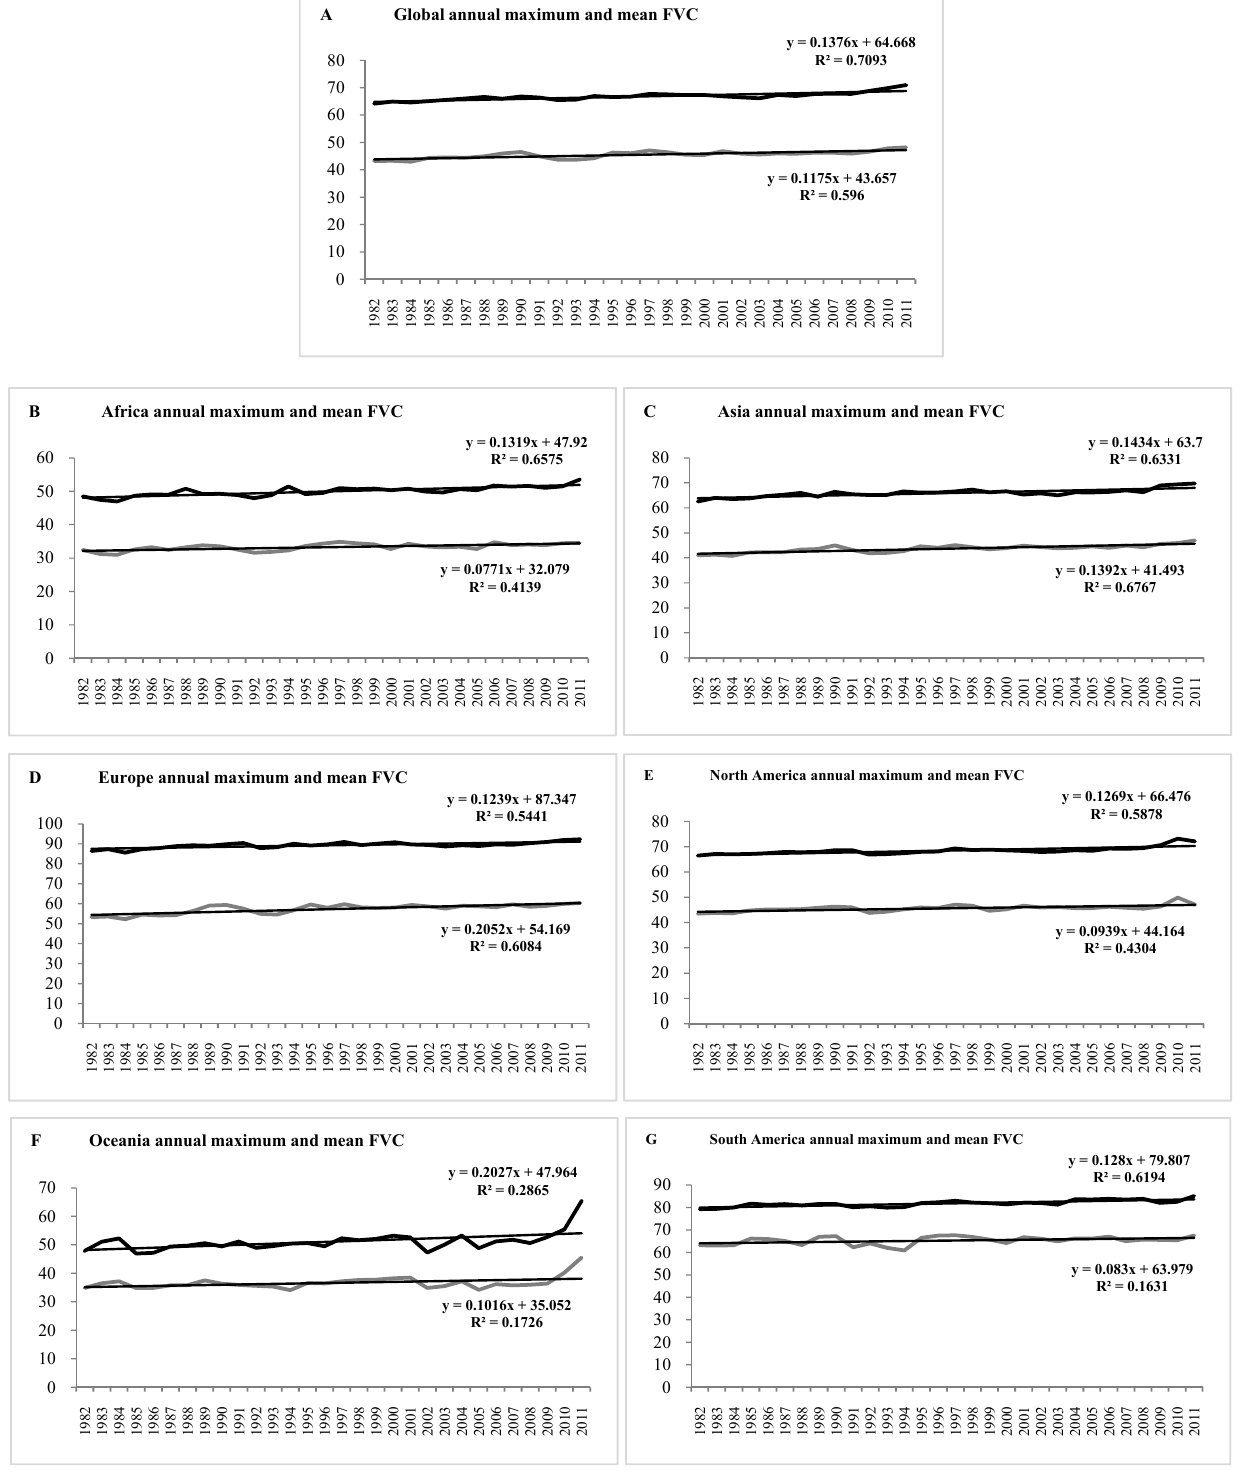
Figure 5. The annual maximum and mean FVC of the seven continents of the world from 1982 to 2011. ( A – G ) Global, Africa, Asia, Europe, North America, Oceania and South America yearly FVC (%) change, respectively. The black lines represent the annual maximum value and grey the annual mean